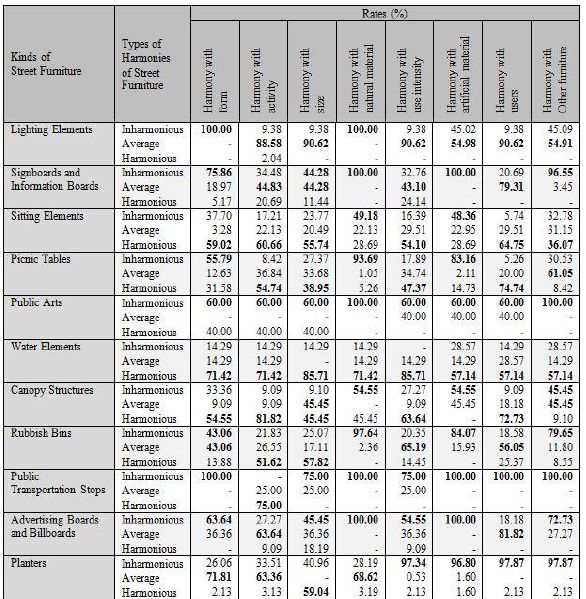
Table 1. The Percentages of the YEDBIS Analysis Results of the Respective Elements of Street Furniture.